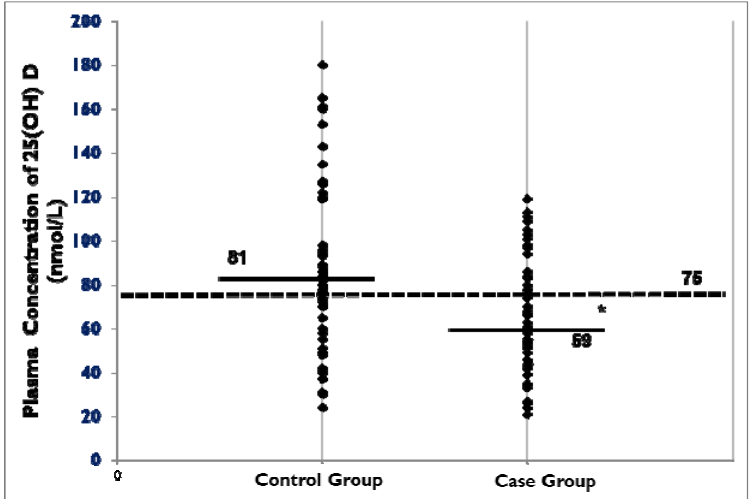
Figure 1. Plasma concentration of 25(OH) D across case and control